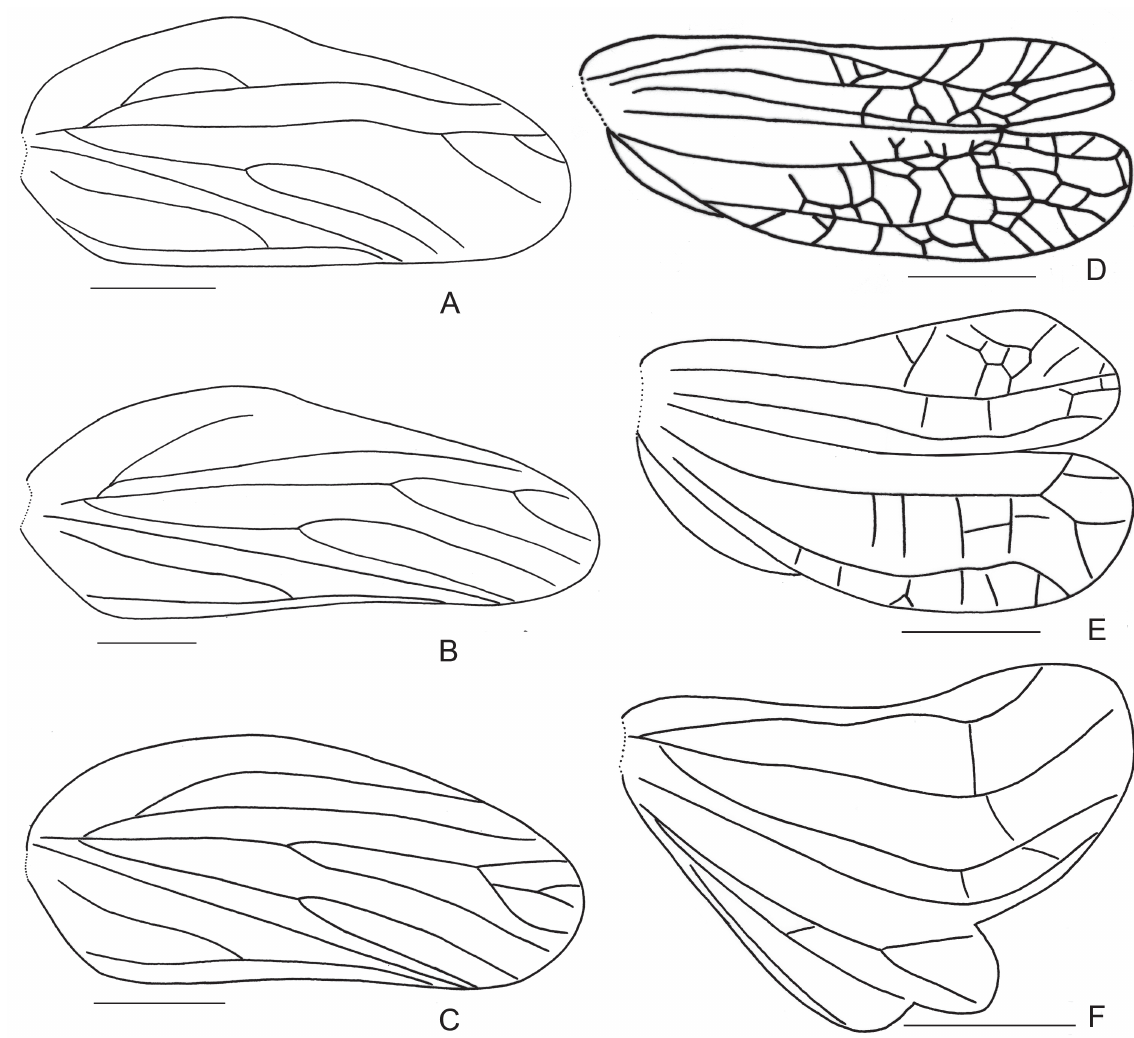
Fig. 2. Tegmen. A . Sarima sp. B . Sarimodes sp. C . Eusarima sp. — Hind wing. D . Macrodarumoides petalinus Che, Zhang & Wang, 2012, holotype. E . Gelastyrella litaoensis Yang, 1994. F . Dentatissus damnosus (Chou & Lu, 1985). Scale bars = 1